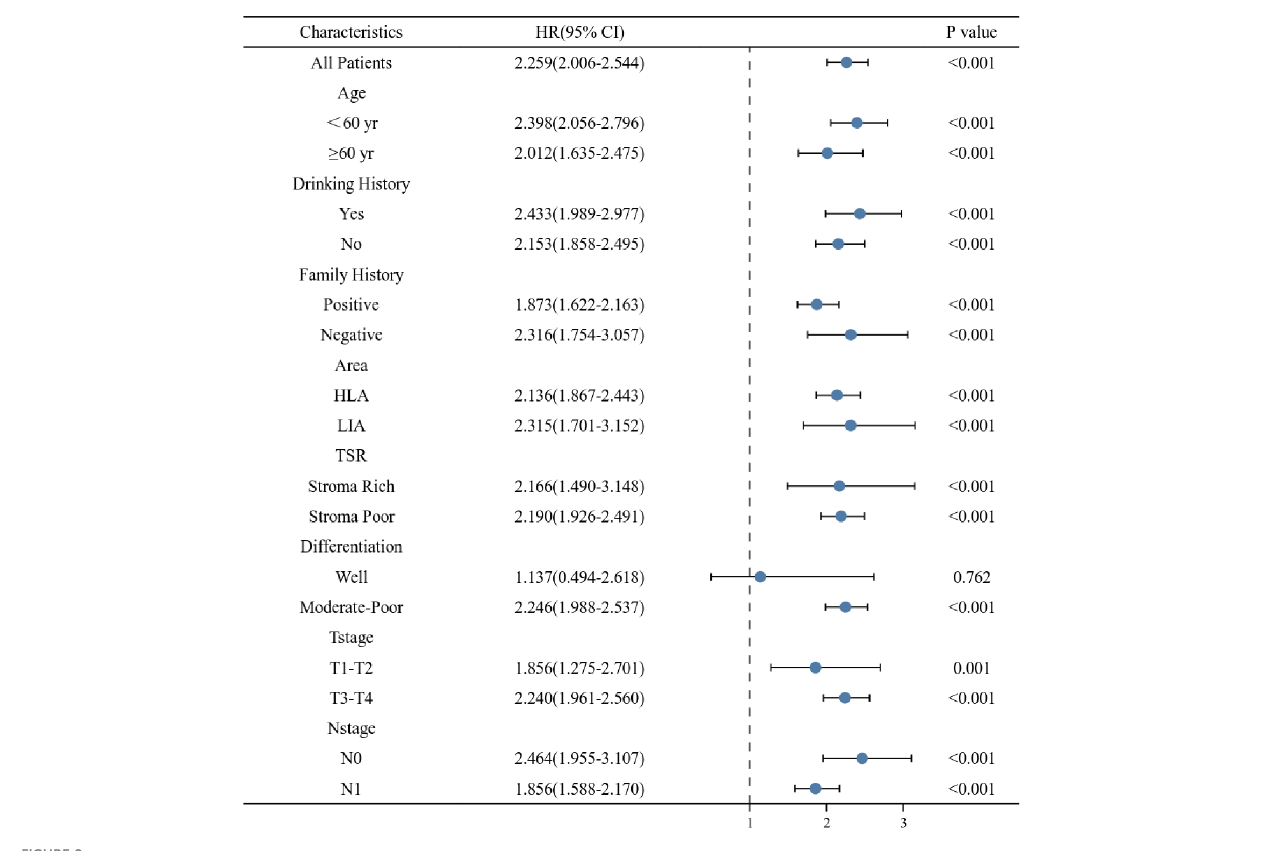
FIGURE 8 Strati fi ed analysis of the clinical-pathological nomogram model in different